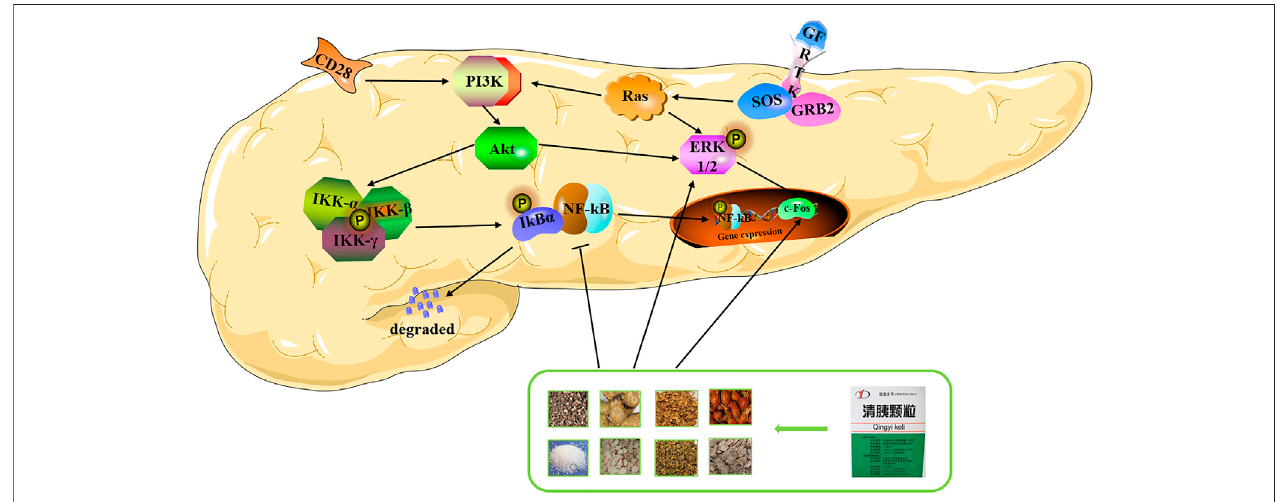
FIGURE 8 | Overview of potential mechanisms underlying the protective effects of QYD on STC-induced acute